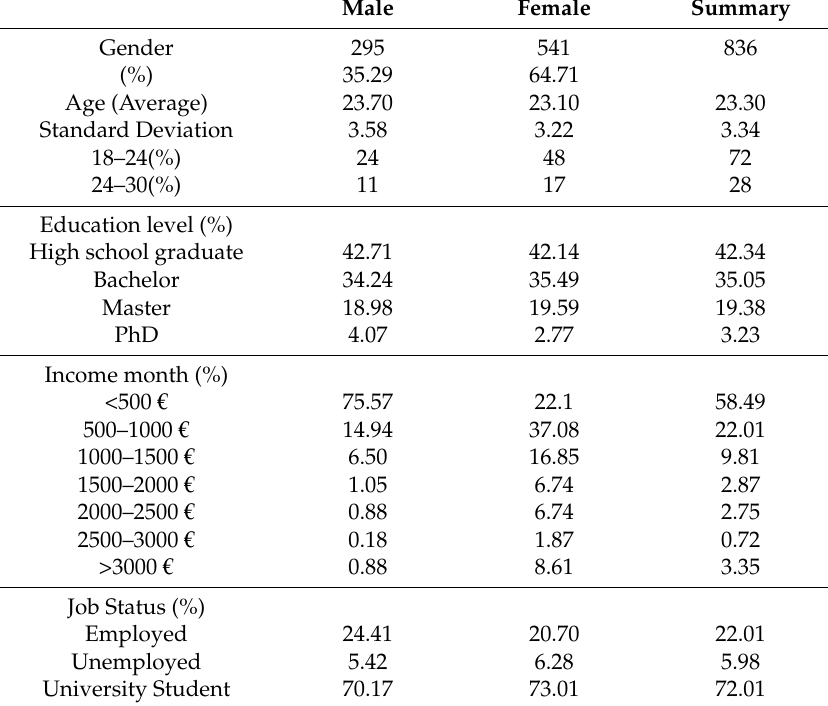
Table 1. Demographics of overall sample ( n = 836).